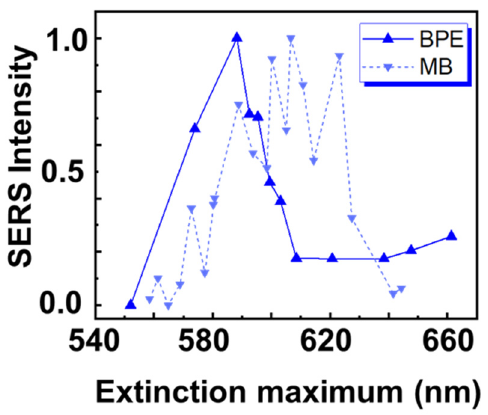
Figure 4. Plot comparing the SERS intensity for the two molecules BPE and MB to the extinction maximum of the LSPR (without analyte).